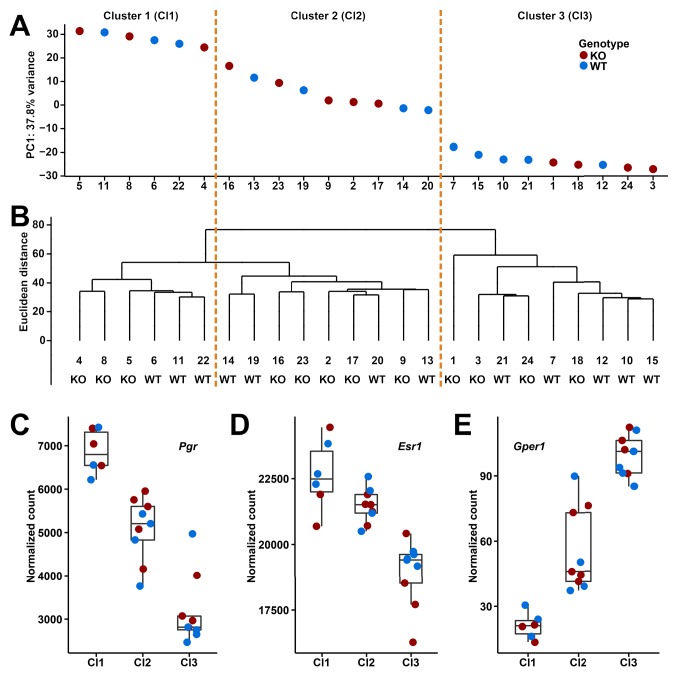
Clusters and expression levels in the 24 RNA-Seq samples of oviducts.(A) PC1 values from the PCA analysis, (B) hierarchical clustering result. Sample codes and genotypes are listed along X-axis. The 24 samples are assigned into three clusters accordingly. (C-E) The expression levels of three sex hormone receptor genes (Pgr, Esr1, Gper1) are shown by box plots.